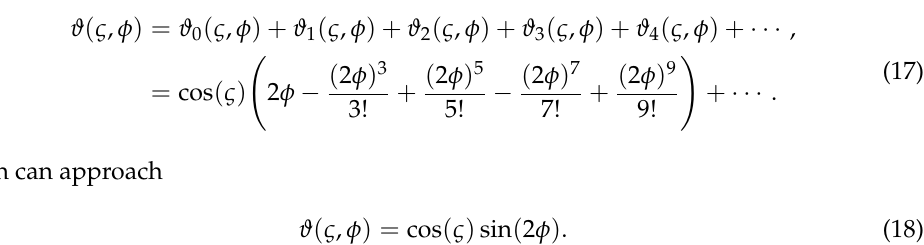
Figure 1 contains two diagrams: (a) the A HITM results of ϑ ( ς , φ ) and (b) the exact results of ϑ ( ς , φ ) at − 2 ≤ ς ≤ 2 and 0 ≤ φ ≤ 0.5 for a 1D wave problem. Figure 2